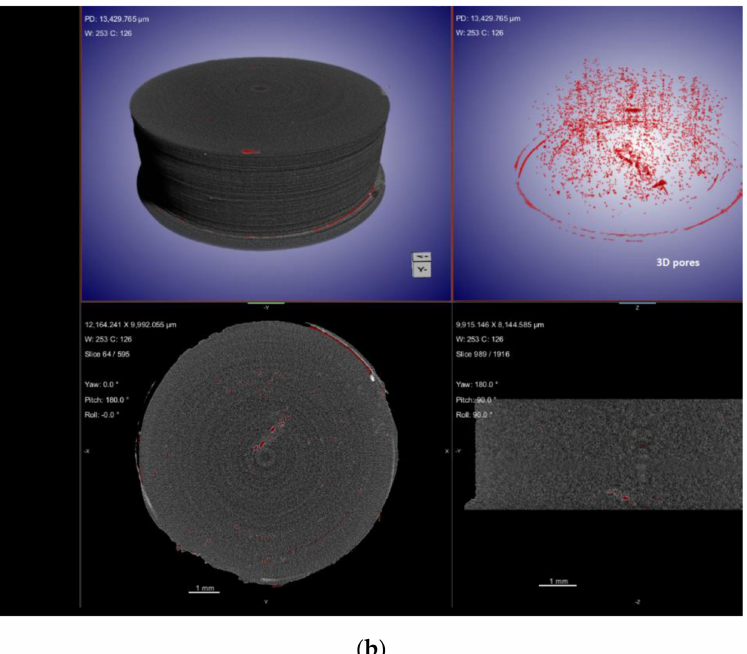
Figure 7. X µ CT images showing material deposition and 3D pore distribution (red) in 3D-printed tablets containing ( a ) 20% w / w NAP and ( b ) 30% w / w NAP. Adapted from [123] under